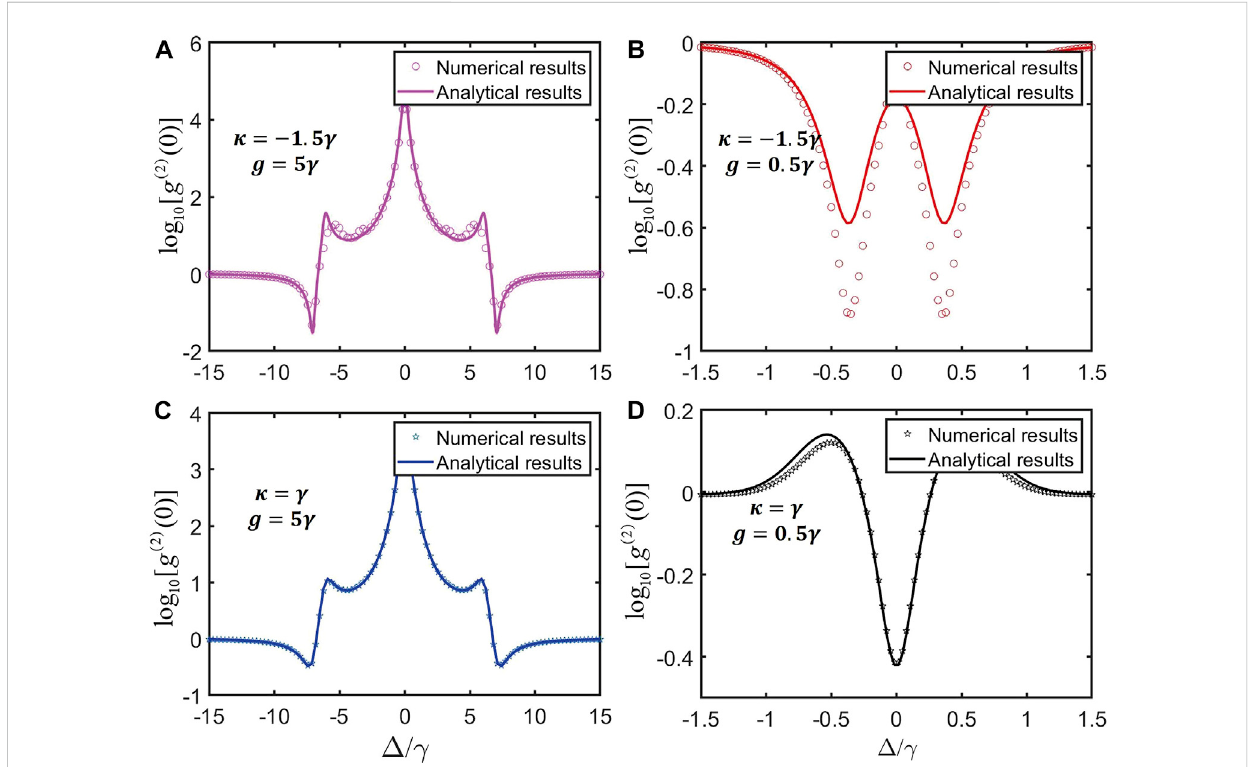
FIGURE 2 Inthesystemwiththegain(dissipation)cavity,thelogarithmicplotsofthesecond-ordercorrelationfunction g ( 2 ) ( 0 ) asafunctionofthenormalized detuning Δ / γ for two cases: (A, C) the system in the strong coupling regime, while (B, D) in the weak coupling regime. Here, the other parameters are chosen as Δ 1 (cid:1) Δ 2 (cid:1) Δ c (cid:1) Δ . The driving strength takes as ε (cid:1) 0 . 1 γ in the following fi